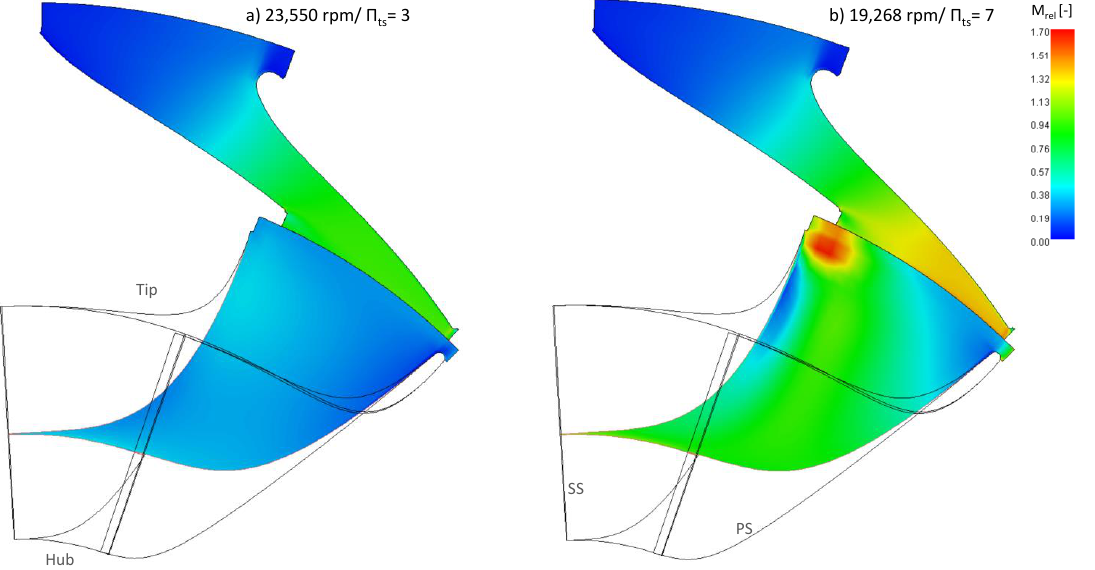
Figure 12. Off-design relative Mach number distribution at mid-span from 3D CFD simulations: ( a ) 23,550 rpm & Π ts = 3, ( b ) 19,268 rpm & Π ts = 7.